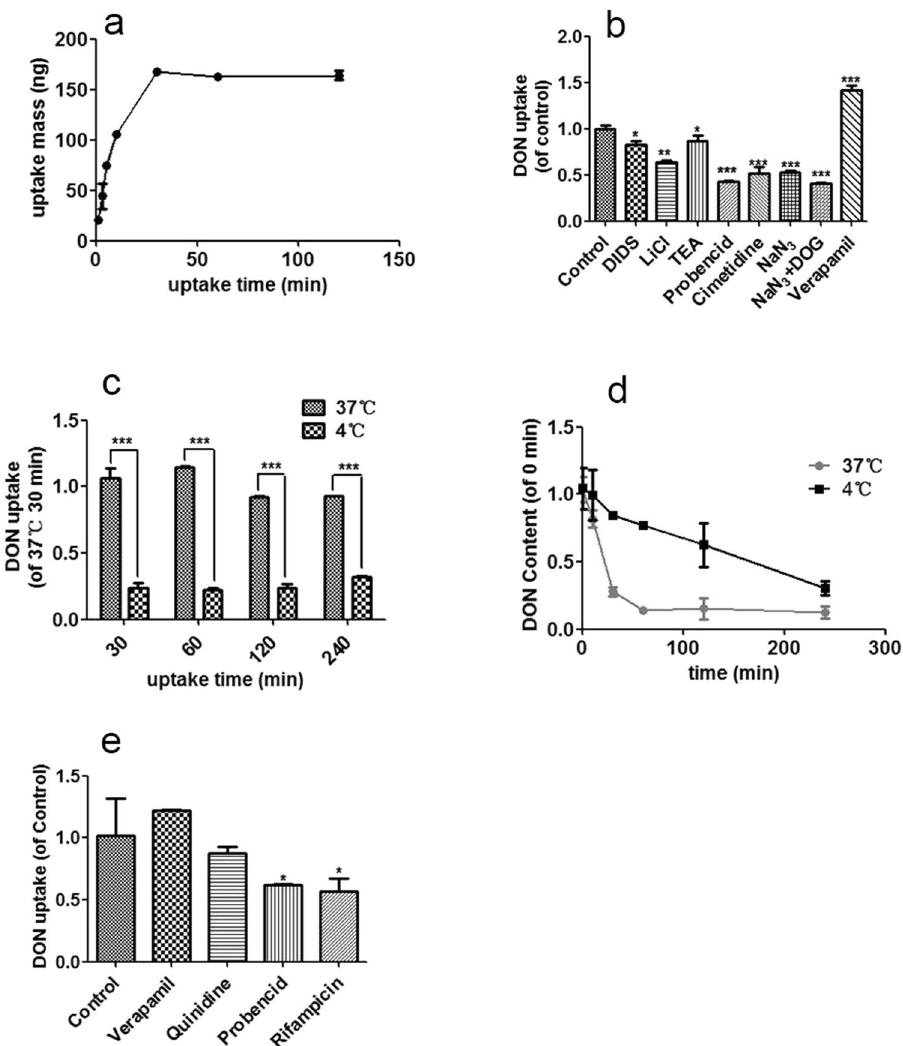
Figure 4. Characterization of DON transport in MDCK cells and HepG2 cells. ( a ) Time course of the transport of 20 μ g/ml DON in MDCK cells; the data are presented as the mean values ± SD (n = 3) and are normalized to total protein concentrations; the total protein concentration measured at 1 min is set to 1. ( b ) Effects of OAT inhibitors (2 mM DIDS, 2 mM probencid, and 2 mM cimetidine), OCT inhibitors (2 mM TEA and 2 mM cimetidine), metabolic inhibitors (2 mM NaN 3 , 2 mM NaN 3 + 50 mM 2-DOG) on the uptake of 20 μ g/ml DON in MDCK cells within 10 min (n = 3). ( c ) Temperature-dependent uptake of 20 μ g/ml DON in MDCK cells. ( d ) Temperature-dependent efflux of DON (n = 3) from MDCK cells. ( e ) Effects of the OAT inhibitor (100 μ M probencid), OCT inhibitor (100 μ M quinidine), OATP inhibitor (100 μ M rifampicin) and P-glycoprotein inhibitor on the uptake of 5 μ g/ml DON in HepG2 cells within 5 min (n = 3).